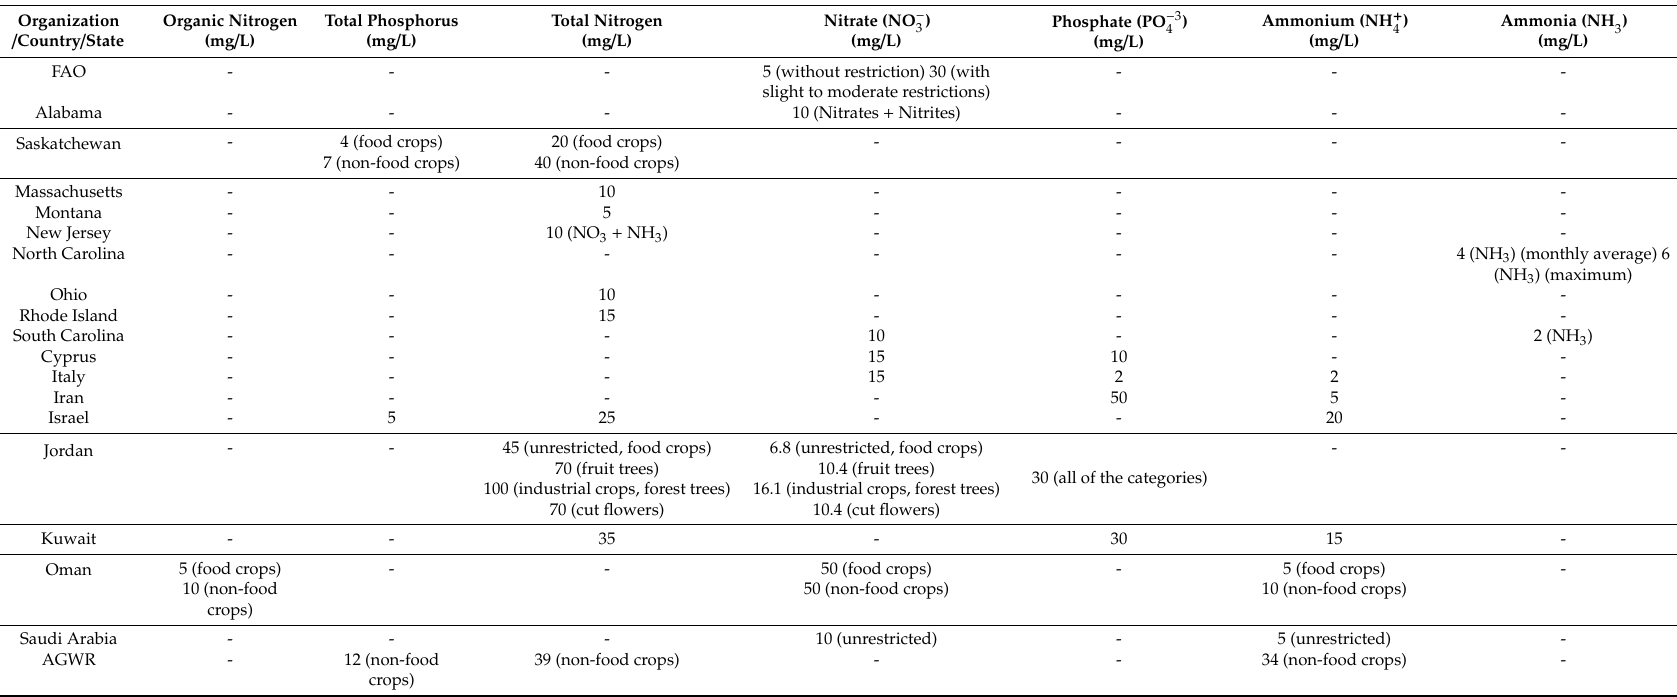
Table 13. Nutrients thresholds in agricultural water reuse regulations and